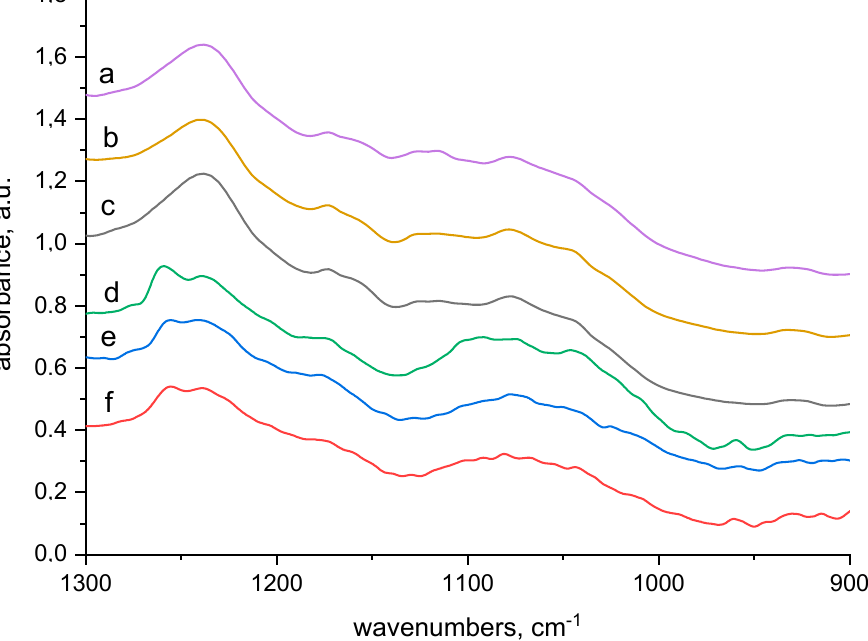
Figure 3. Spectra of reference materials (without CuSO 4 treatment), from up to down: (a) transmission spectrum of wool with 0 kGy dose; (b) transmission spectrum of wool with 24 kGy dose; (c) transmission spectrum of wool with 165 kGy dose; (d) ATR spectrum of wool with 0 kGy dose; (e) ATR spectrum of wool with 24 kGy dose; (f) ATR spectrum of wool with 165 kGy dose.